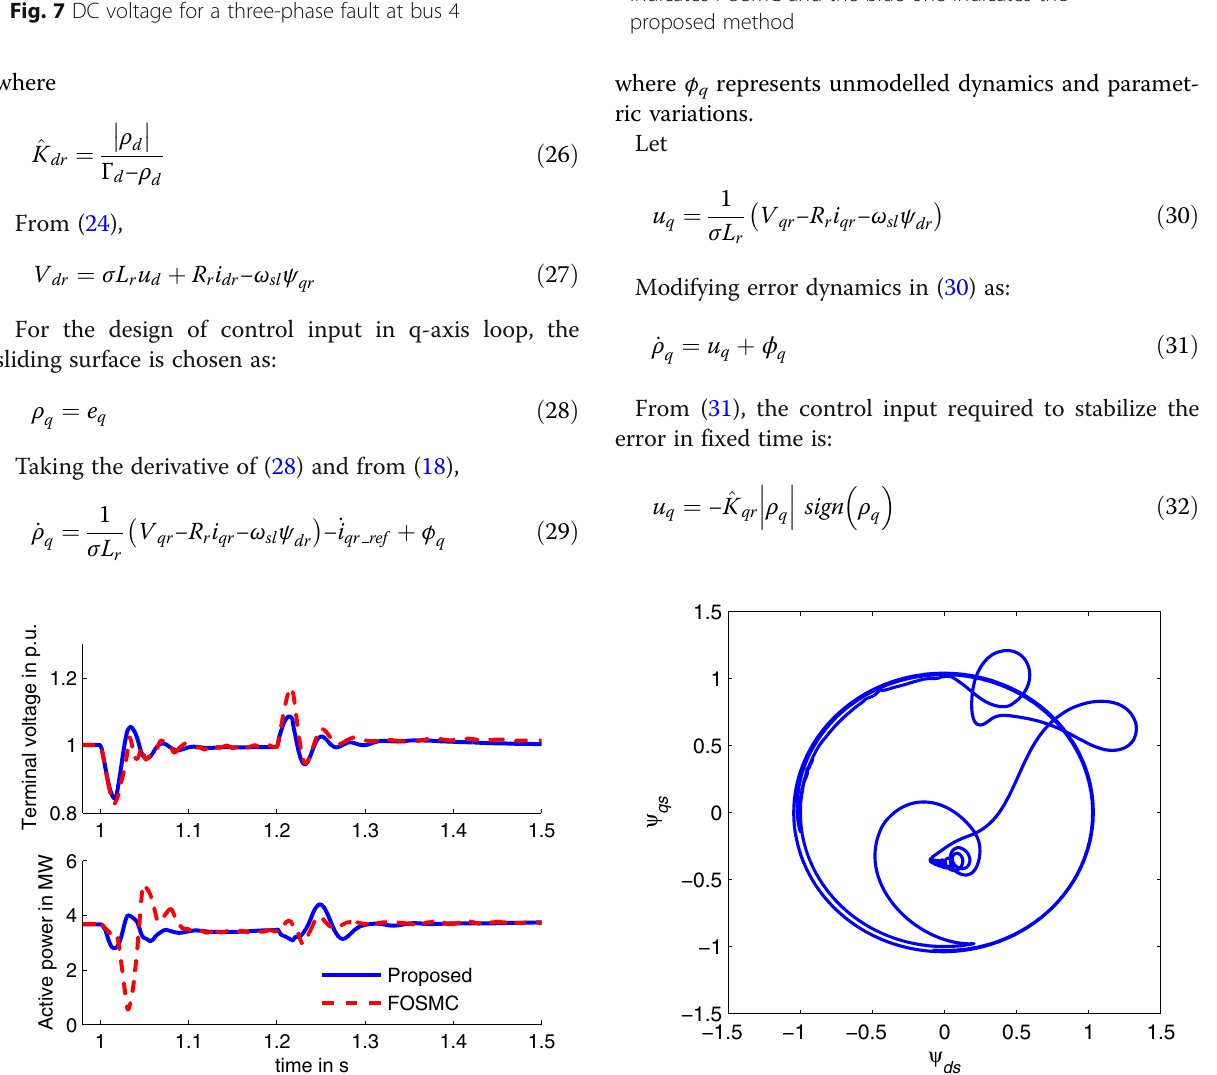
Fig. 8 Comparison of the proposed method with FOSMC